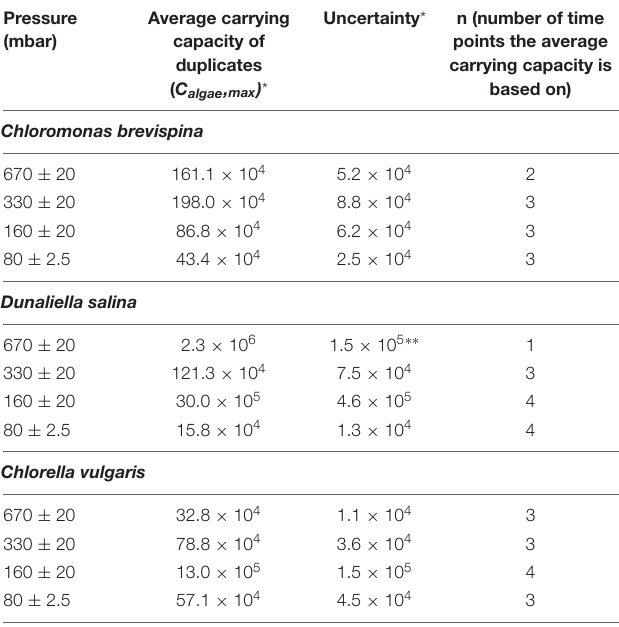
TABLE 2 | Table showing the carrying capacities ( C algae , max ) computed at different pressures for Chlorella vulgaris (CV) Dunaliella salina (DS), and Chloromonas. Pressure Average carrying Uncertainty * n (number of time (mbar) capacity of points the average duplicates carrying capacity is ( C algae , max ) * based